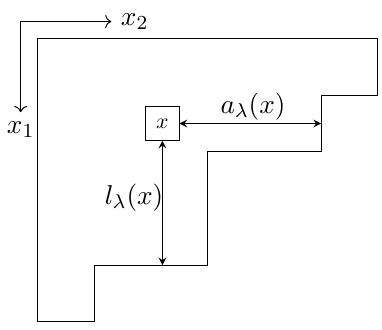
Figure 5 . Arm and leg length of a box x = ( x 1 , x 2 ) in a Young